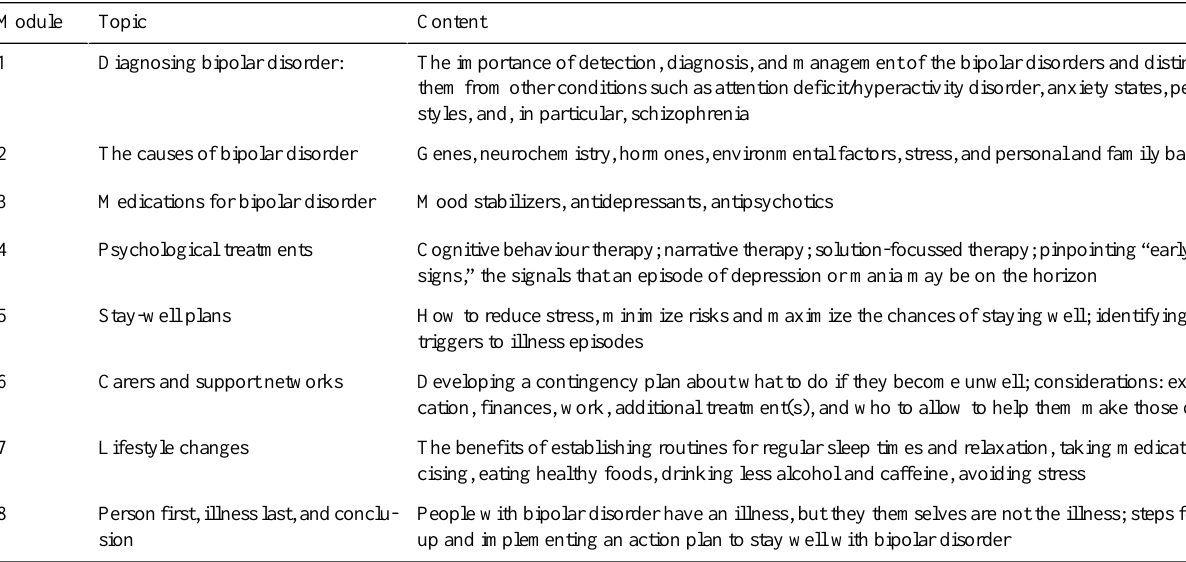
Table 1. Content of the Online Bipolar Education Program ContentTopicModule The importance of detection, diagnosis, and management of the bipolar disorders and distinguishing styles, and, in